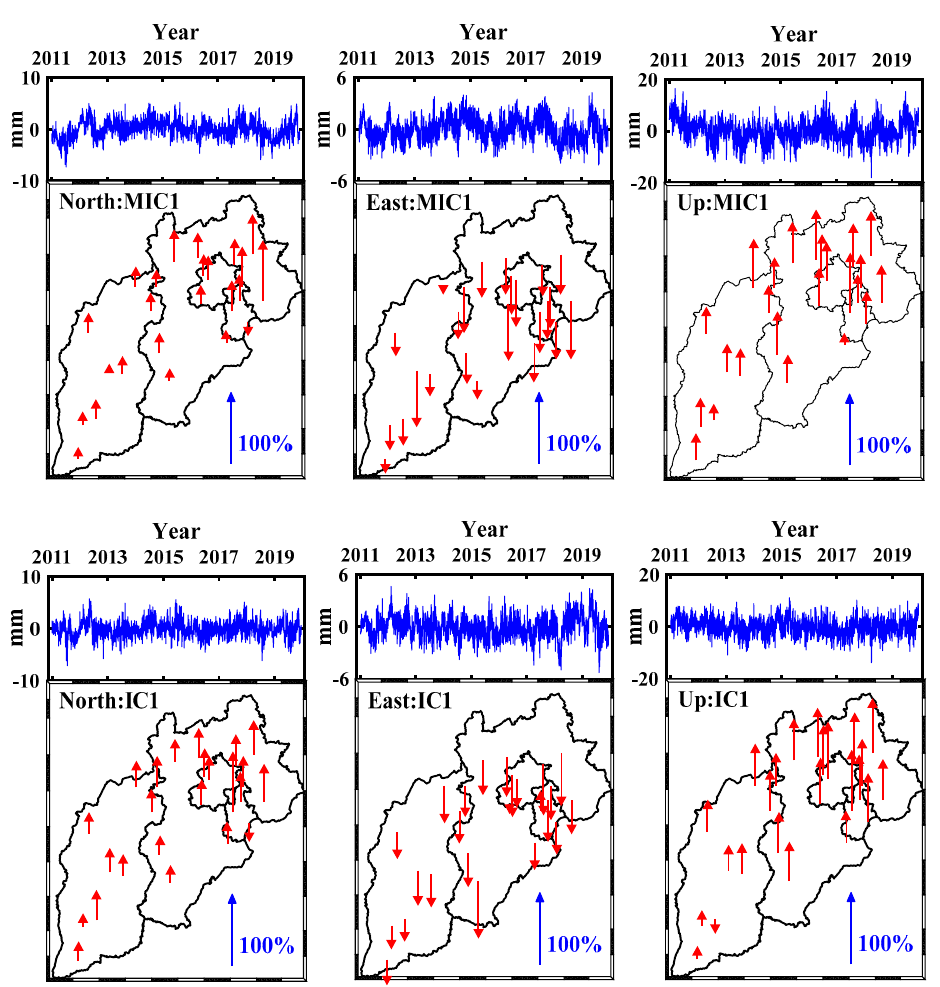
Figure 6. The first MICs and ICs for the three coordinate components. ( Top ) scaled temporal responses (TRs) and ( bottom ) normalized spatial responses (SRs).